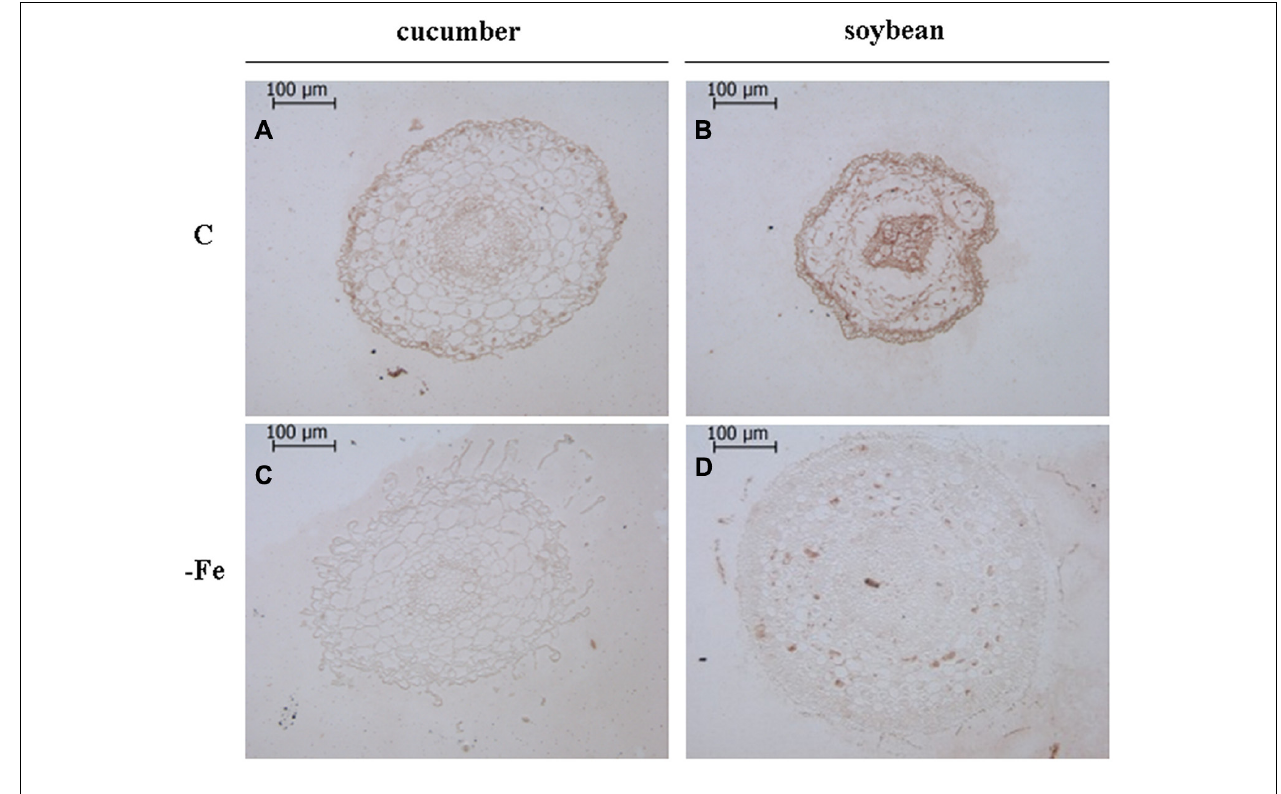
FIGURE 2 | Immunolocalization ofV-ATPase in cross sections of 8-day-old cucumber and 11-day-old soybean roots. C: control (Fe-sufficient) cucumber (A) and soybean (B) root sections; − Fe: Fe- deficient cucumber (C) and soybean (D) root sections. Root sections